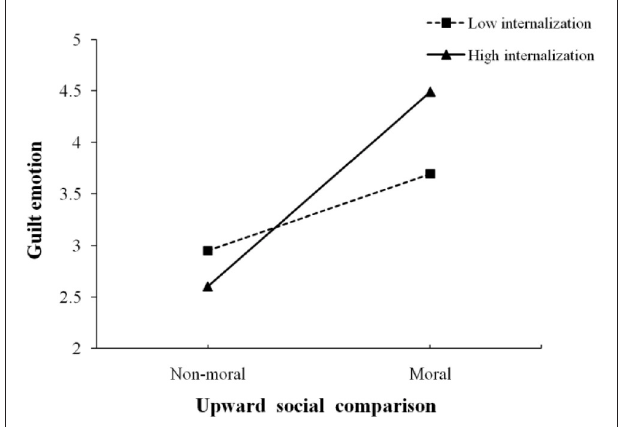
FIGURE 2 | Simple slopes for the effect of the interaction between upward moral comparison and moral identity internalization on